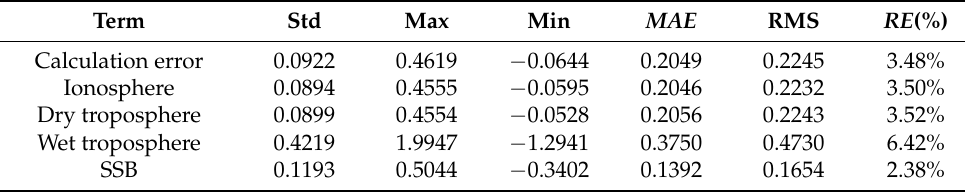
Table 4. Statistics of GA errors caused by different residual environmental errors (unit: